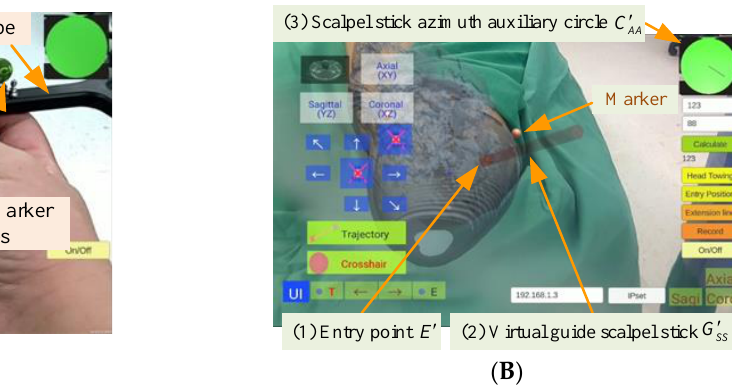
Figure 9. AR scalpel superimposition. ( A ) Superimposed 4-marker images and scalpel stick. ( B ) Superimposed AR head model and guide scalpel stick.